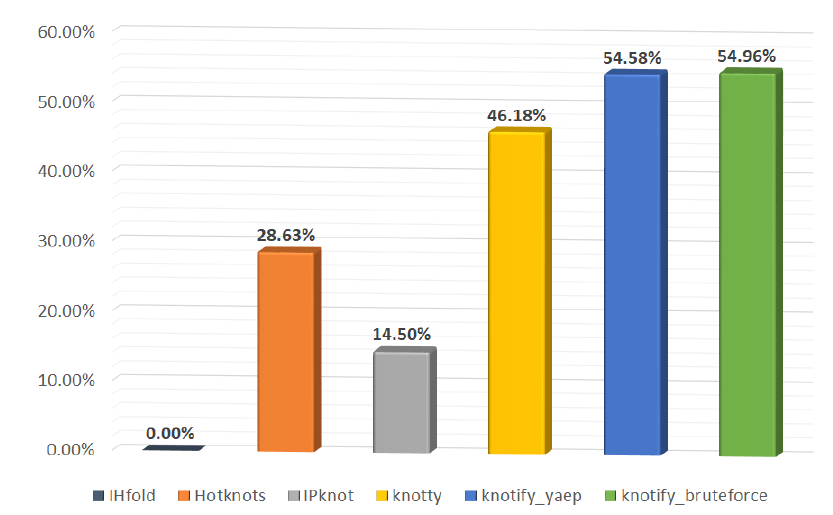
Figure 8. Percentage of pseudoknot’s core stems exact prediction per platform.